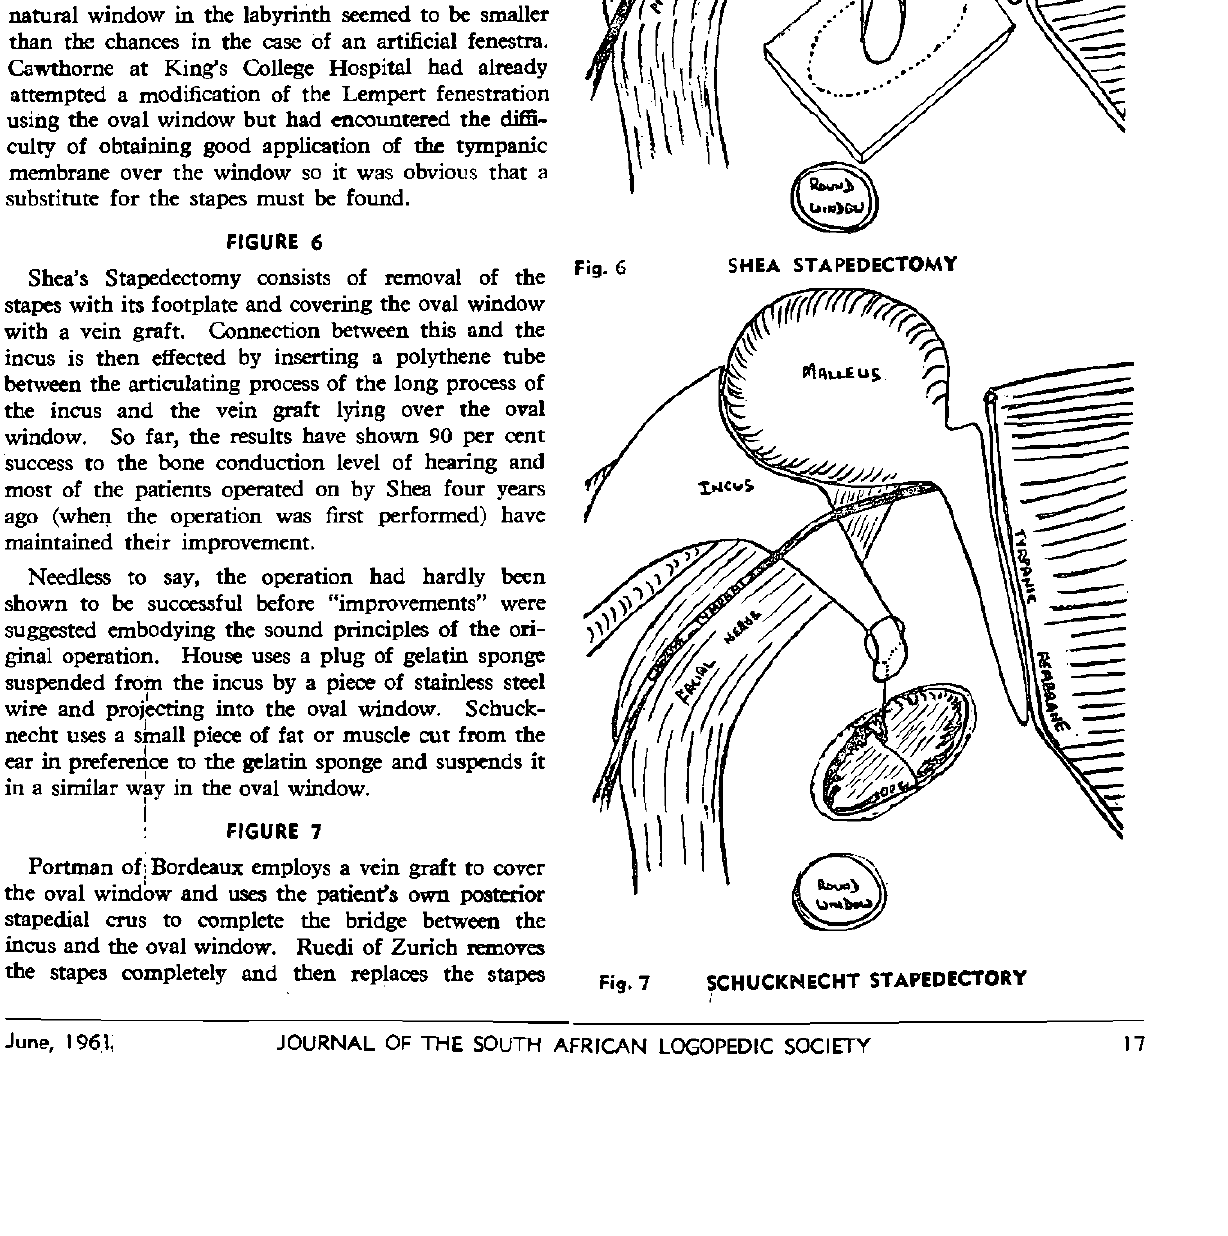
FIGURE 7 Portman of; Bordeaux employs a vein graft to cover